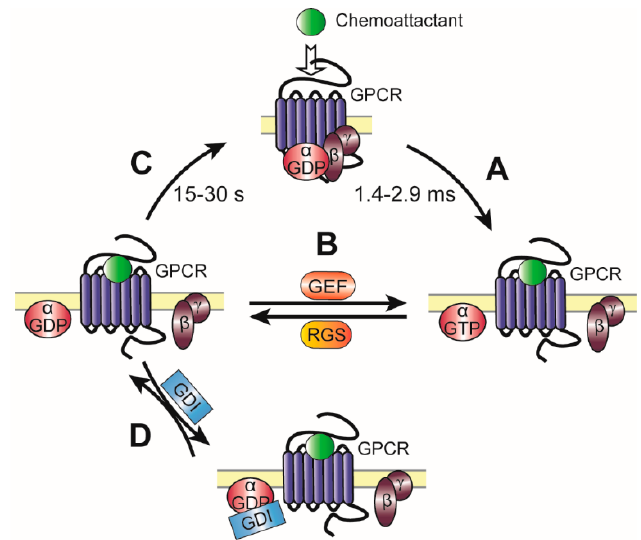
Figure 2. A schematic representation of mammalian G α regulation. Upon binding of extracellular chemoattractant, GPCRs undergo conformational changes to act as guanine nucleotide exchange factors (GEFs) for G α subunits, facilitating GDP release and subsequent binding of GTP, and release from G βγ dimers ( A ) Non-receptor GEFs can bind to G α -GDP and extend G α subunit activation by stimulating the exchange of G α -GDP to the active GTP-bound state. Regulator of G protein signaling (RGS) proteins stimulate the exchange of G α -GTP back to G α -GDP, serving as GTPase-accelerating proteins (GAPs) for G α , thereby dramatically enhancing their intrinsic rate of GTP hydrolysis; ( B ) Upon GTP hydrolysis of G α , the heterotrimer of G α -GDP and G βγ can reform, restoring the coupled GPCR/G protein complex; ( C ) However, in the presence of guanine nucleotide dissociation inhibitors (GDIs), G α can become trapped in a G α ·GDP/GDI complex, preventing G βγ from reassociation and re-coupling to GPCRs ( D ).